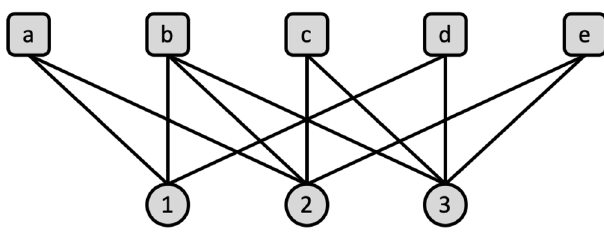
Figure 1. An example of a bipartite graph with 8 nodes and 11